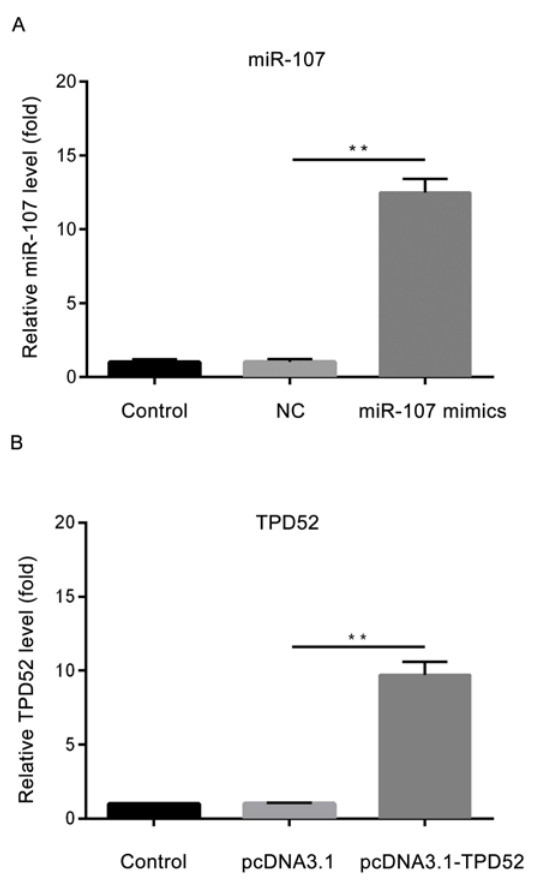
Figure 4: The transfection efficiency of miR-107 and TPD52. (A) The expression level of miR-107 in different groups; (B) The expression level of TPD52 in different groups. **P<0.01, miR-107 mimics vs NC; pcDNA3.1-TPD52 vs pcDNA3.1. Control, un-treated cells; NC, microRNA-107 mimics negative control-transfected cells; miR-107 mimics, microRNA-107 mimics-transfected cells; pcDNA3.1, cells transfected with pcDNA3.1; pcDNA3.1-TPD52, cells transfected with pcDNA3.1-TPD52; miR-107, microRNA-107; TPD52, tumor protein D52. The expression level of miR-107 is significantly higher in miR-107 mimics group. The transfection efficiency of miR-107 was confirmed by RT-qPCR assay. **P<0.01, vs miR-NC mimics group. Control, un- treated cells; NC, microRNA-107 mimics negative control-transfected cells; miR-107 mimics, microRNA-107 mimics-transfected cells.